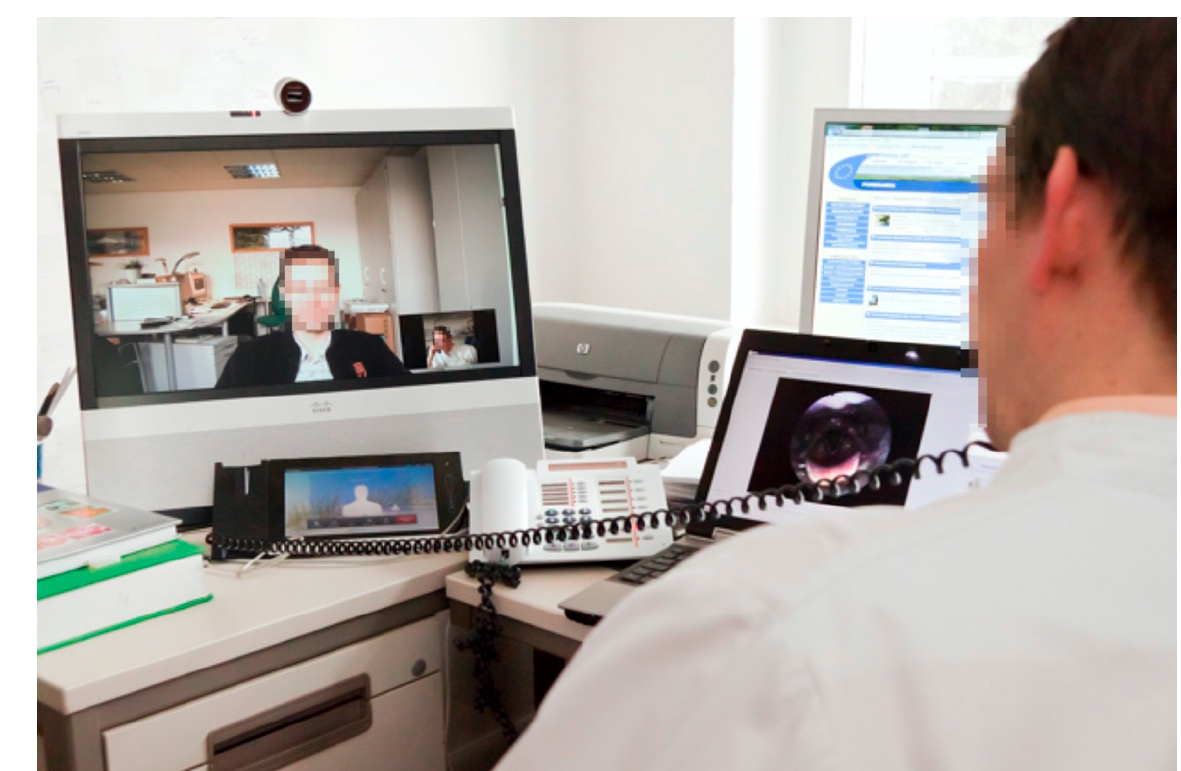
Figure 10. Video endoscopy during an ENT consultation. A non-specialised physician inserted the endoscope and images were automatically transferred to the specialist in a university hospital—in our project, between Templin and Greifswald. The distance between the two cities was roughly 150 km, and the driving time would be nearly 2 h. Specialised diagnosis was thus possible despite the distance, and therapy recommendations could be given. The Greifswald ENT specialist in the image is seen from the back, the general physician in Templin is shown on the monitor of the videoconferencing unit, and the image generated by the endoscope is shown on a smaller monitor to the right.